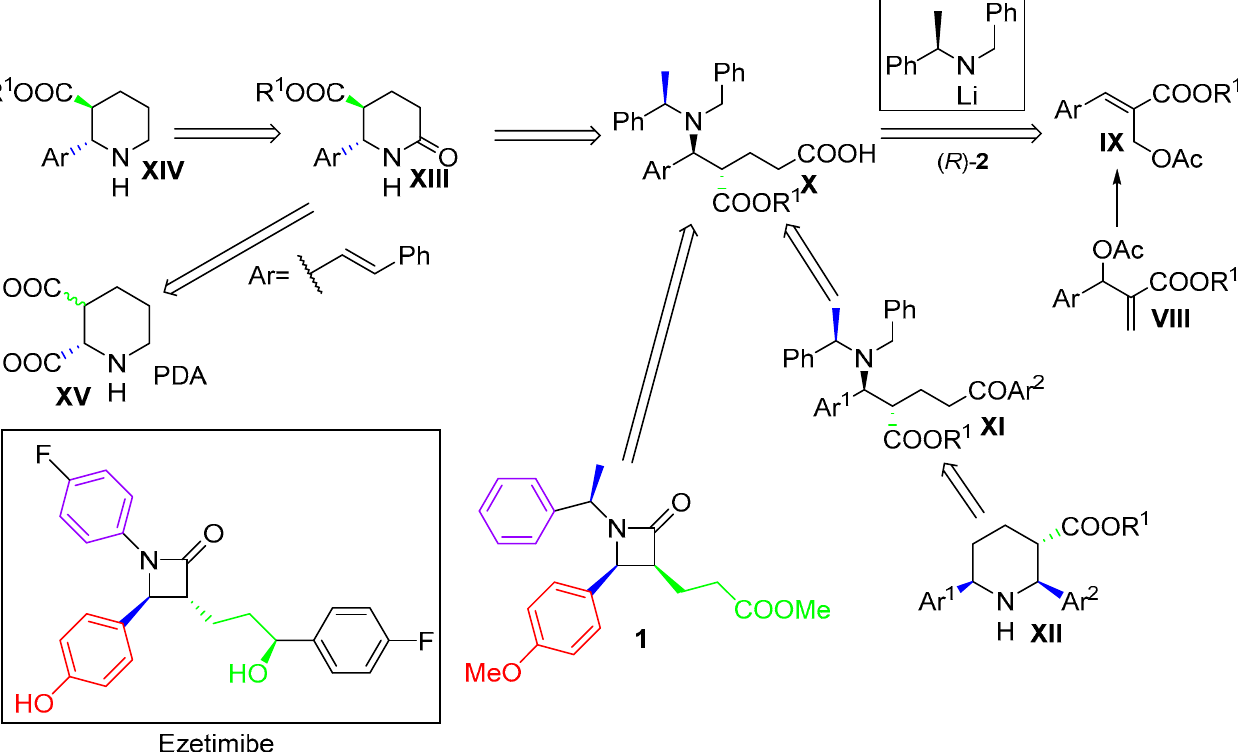
Scheme 2. Retrosynthesis of 2,3-disubstituted and 2,3,6-trisubstituted piperidines, as well as Ezetimibe analogue